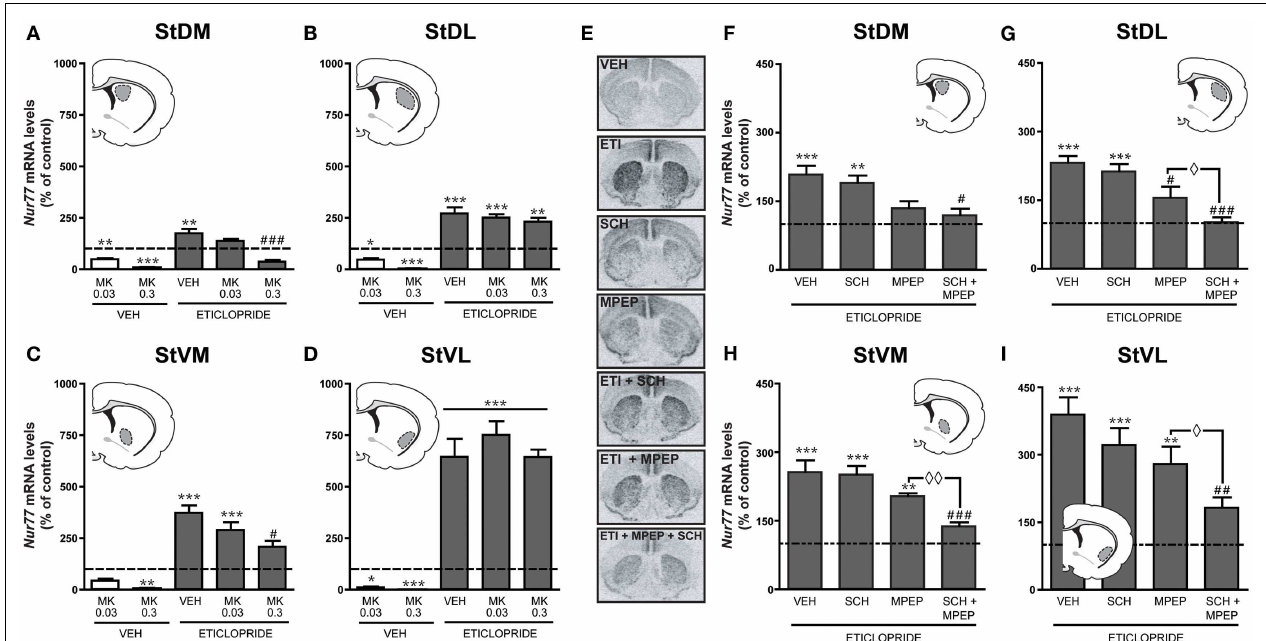
and ### p < 0.001 vs. eticlopride, N = 5 per group). ( E ) Representative autoradiograms showing Nur77 mRNA levels following drug administrations. Inhibitions of eticlopride-induced Nur77 expression (expressed as% of control, dash lines) by the vehicle (VEH), SCH58261 (SCH), MPEP, or SCH + MPEP were measured in ( F ) dorsomedial (StDM), ( G ) dorsolateral (StDL), ( H ) ventromedial (StVM), ( I ) ventrolateral (StVL) portions of the striatum. Nur77 mRNA levels in animal treated withVEH, MPEP, SCH58261, or MPEP + SCH58261 alone can be found in Table 1 . Histograms represent mean ± SEM of eticlopride-treated groups (** p < 0.01 and *** p < 0.001 vs. control; # p < 0.05, ## p < 0.01, and ### p < 0.001 vs. eticlopride alone (VEH); ♦ p < 0.05 and ♦♦ p < 0.01 vs. MPEP + eticlopride, N = 5 per group).